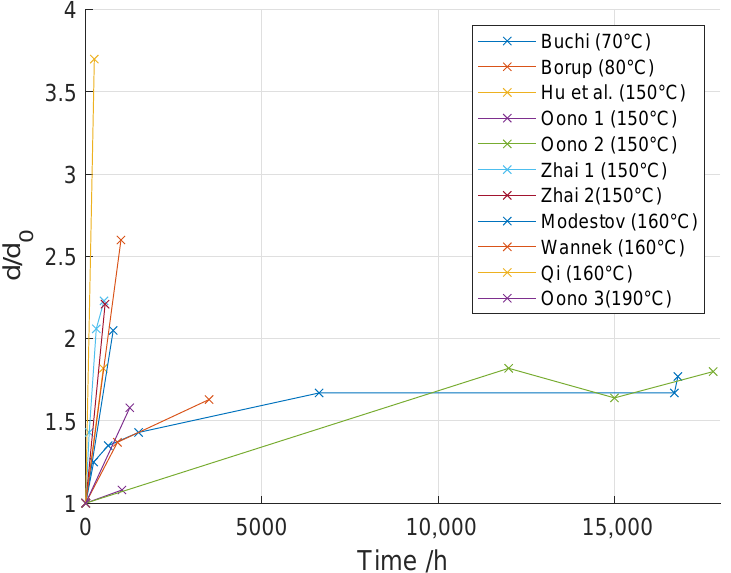
Figure 2. Evolution of d/d 0 over time from the literature data. Data obtained from Buchi (70 °C) [18], Borup (80 °C) [15], Hu (150 °C) [55], Oono 1 (150 °C) [39], Oono 2 (150 °C) [26], Zhai 1 (150 °C) [56], Zhai 2 (150 °C) [17], Modestov (160 °C) [38], Wannek (160 °C) [42], Qi (160 °C) [51] and Oono 3 (190 °C)